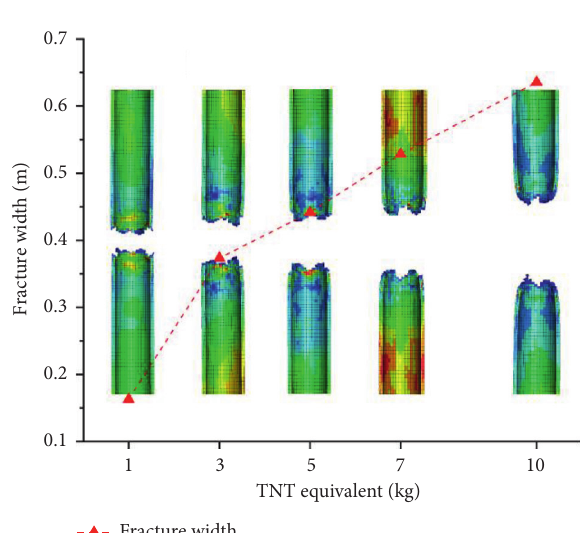
Figure 11: Fracture width of pipes under different TNT